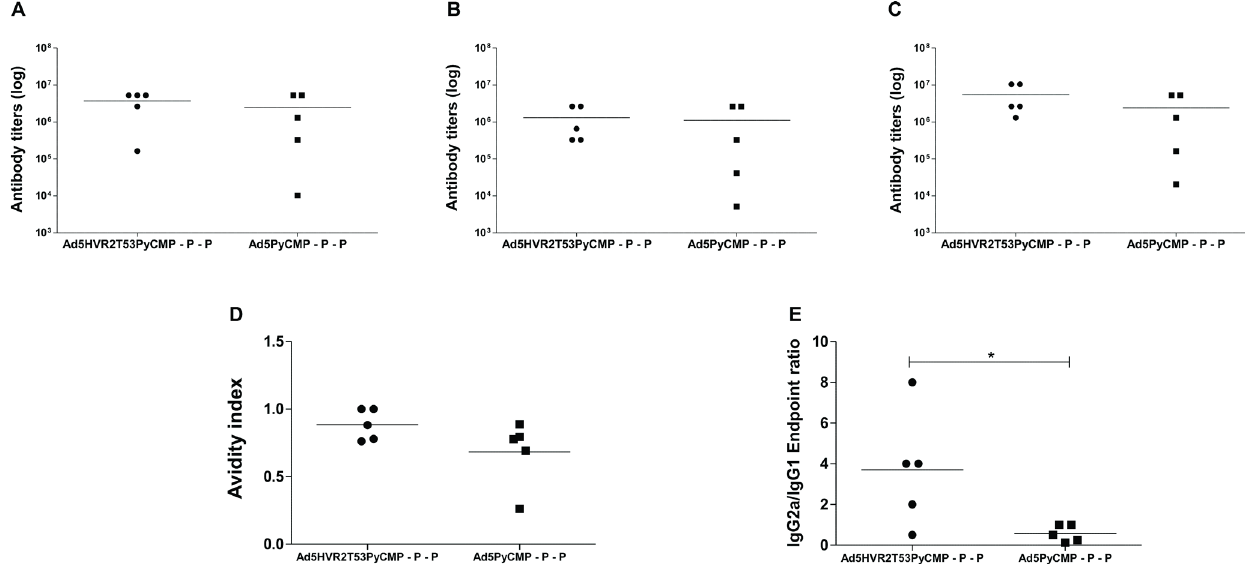
Fig 6. Antibody Responses induced by the vaccination regimen based on the Ad5HVRT53PyCMP vector. CB6F1/J (n = 5 per group) mice were primed with 10 7 v.p. of Ad5 expressing the PyT53 epitope within the HVR2 hexon region and expressing PyCMP as a transgene or Ad5 expressing PyCMP. Both regimens included boosting immunizations at day 60 and at day 90 with the recombinant PyCMP protein. Top. Total IgG antibody titers 20 days after the final immunization expressed as log against the recombinant protein (A) , MSP1 (B) and CSP (C) are presented. The differences between the groups were analyzed by unpaired Student ’ s t test, no significant statistical differences between the groups were found. Bottom. (D) Affinity index of the mice sera samples after treatment with 1M NH4SCN. (E) IgG1 and IgG2a titers were measured separately by isotype-specific ELISA, with sera obtained 20 days after the final immunization. Data are plotted as the ratio of the endpoint log titer of IgG2a/IgG1. Differences between the groups were analyzed by Student ’ s t test, significant differences are denoted by * (p <